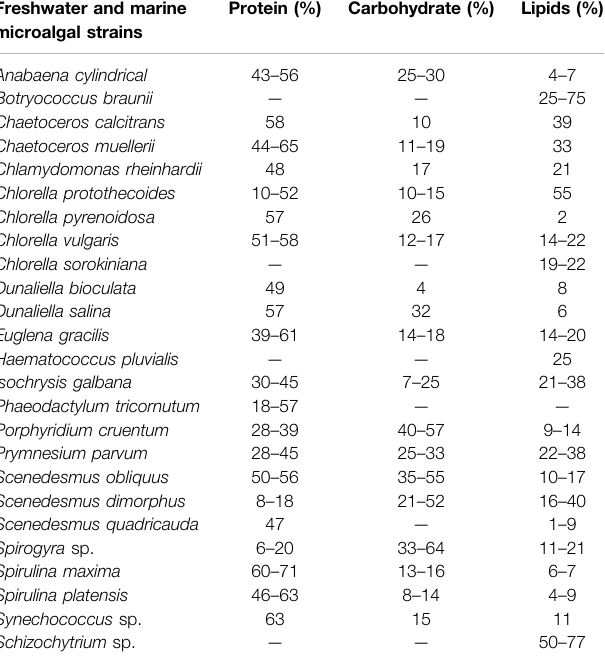
TABLE 4 | Biochemical composition of important freshwater and marine microalgal and cyanobacterial strains for biofuel production (% of dry matter) (Mata et al., 2010; Katiyar et al., 2017; Shuba and Ki fl e, 2018). Freshwater and marine microalgal